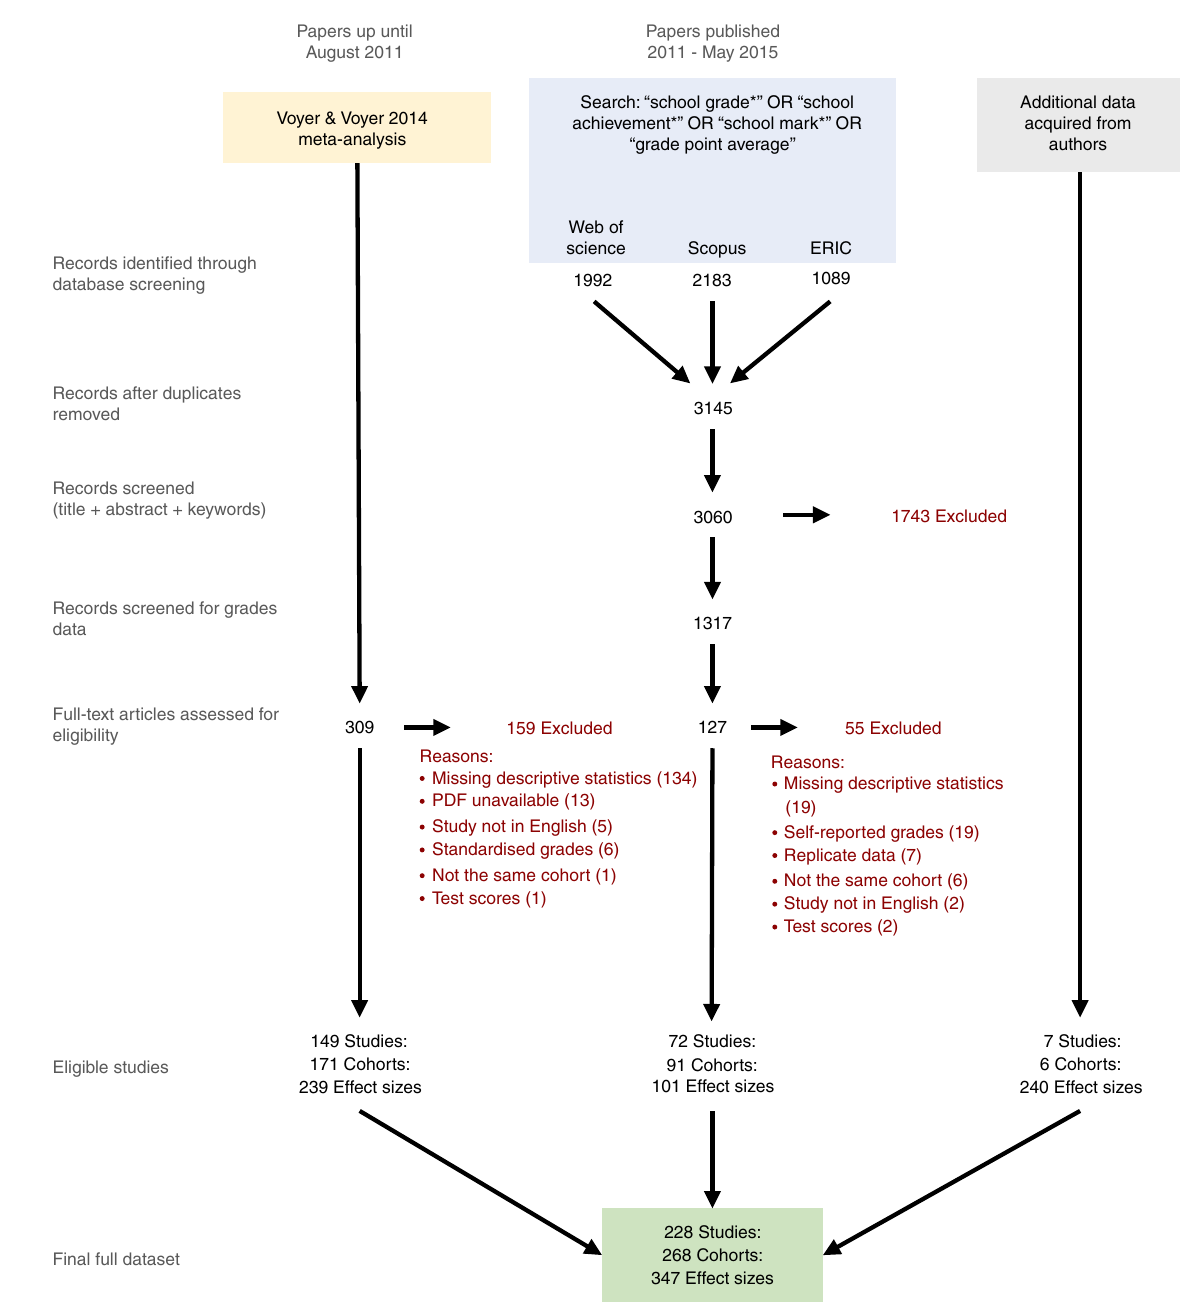
Fig. 4 PRISMA diagram showing the process of locating studies included in this meta-analysis. The full list of included studies, and the list of studies excluded at the stage of full-text screening, are available in Supplementary Data 1 and